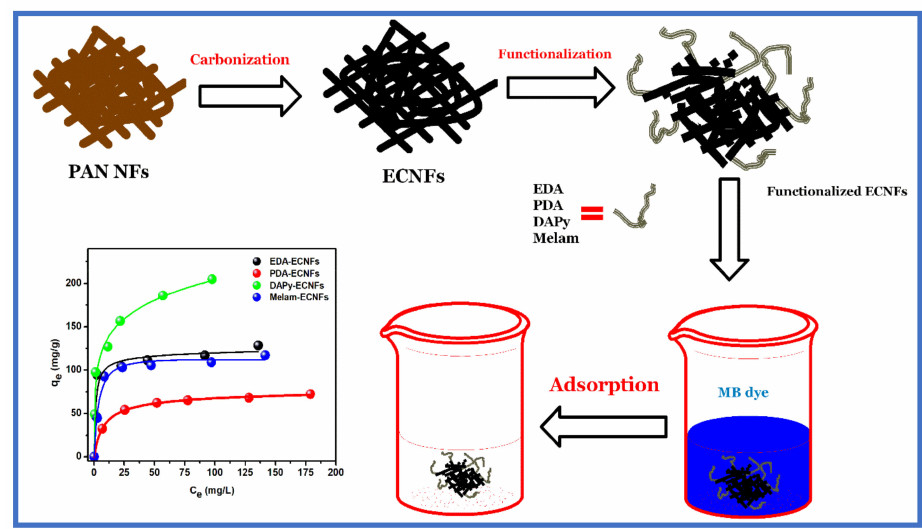
Figure 9. Fabrication and functionalization of ECNFs as a nanoadsorbent for removal of MB dye [217], Copyright © (2020)